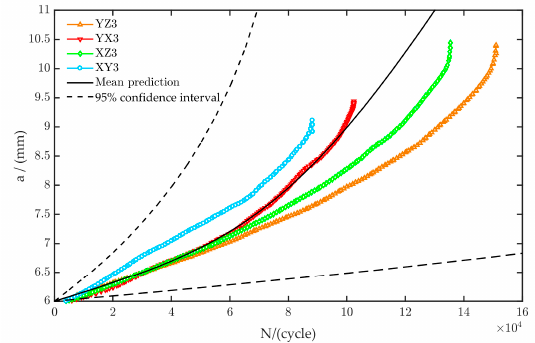
Figure 10. Prediction curve and actual data of fatigue crack growth behavior of CT specimens.